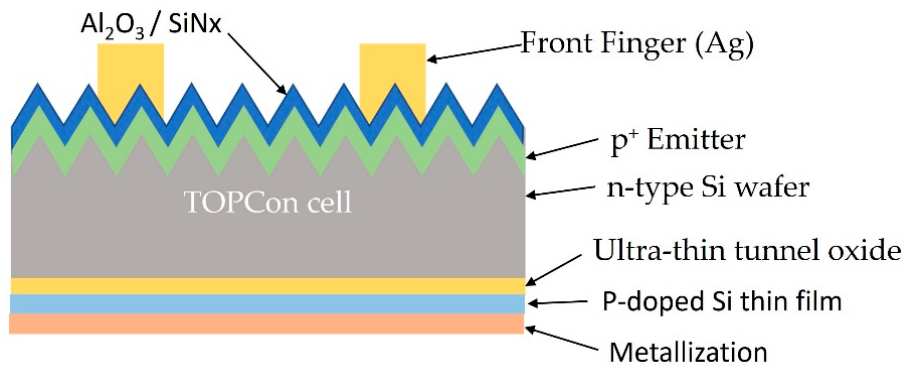
Figure 7. Schematic diagram of TOPCon solar cell.